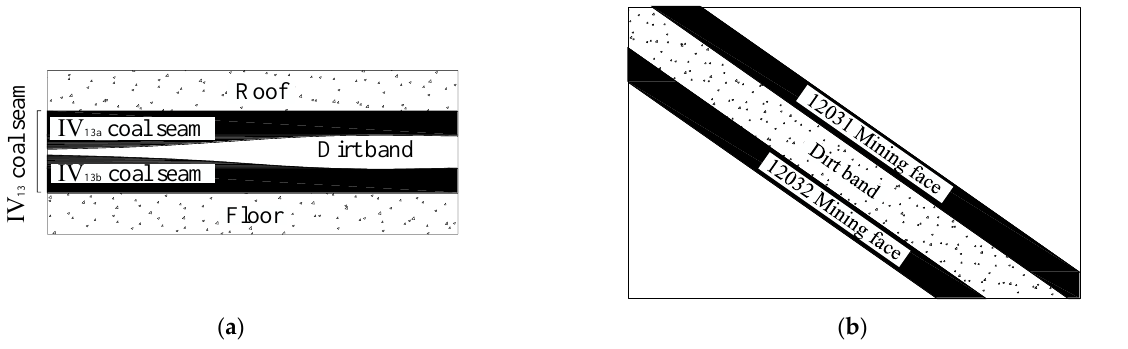
Figure 1. Spatial structure of coal seam. ( a ) Strike profile diagram; ( b ) inclination profile diagram.